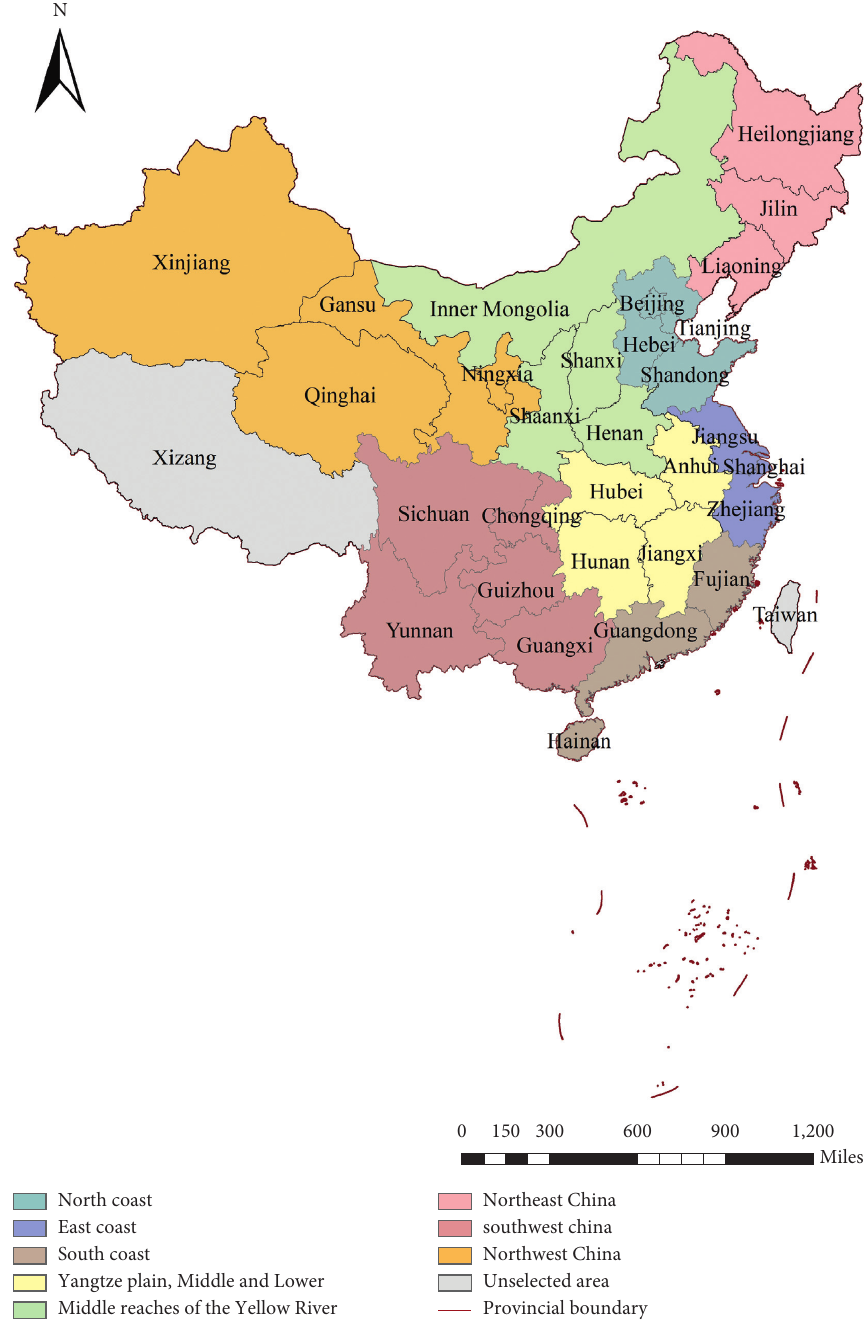
Figure 5: The subdivision of the study area into eight major